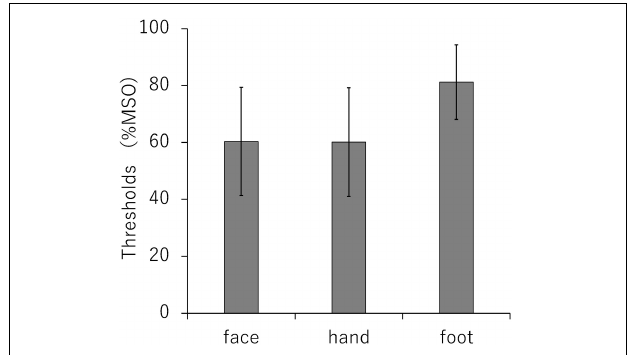
FIGURE 5 | Comparison of resting motor thresholds for each stimulation site (primary motor cortex face, hand, and foot area). MSO, maximum stimulus